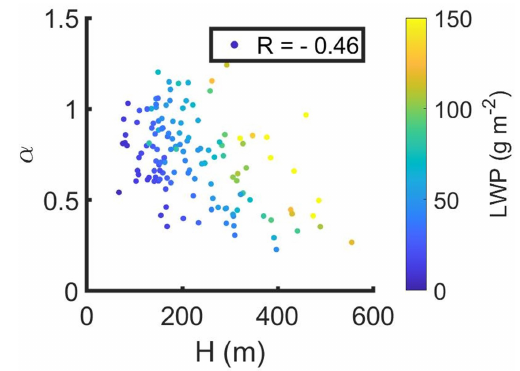
Figure 12. Cloud adiabaticity ( α ) versus cloud thickness ( H ) col- ored by liquid water path (LWP) for profiles with a MODIS retrieval co-located with in situ data for (cid:49)T less than 3600s.